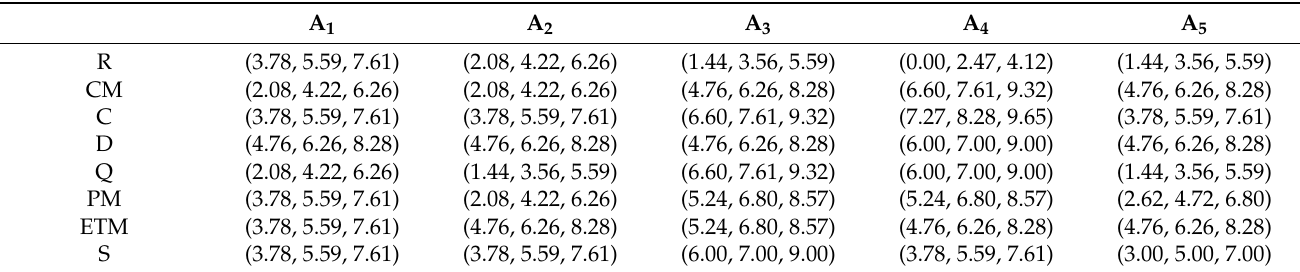
Table 7. Fuzzy aggregated decision matrix.